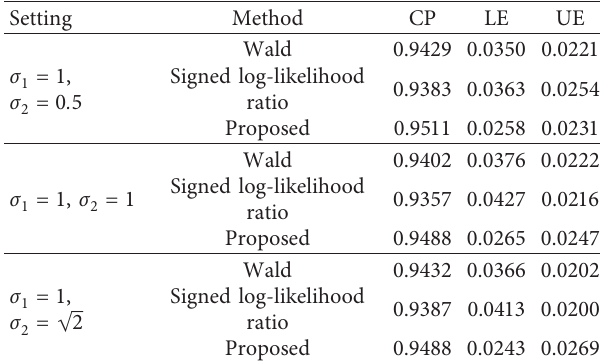
� 12, n � 24, and 1 2